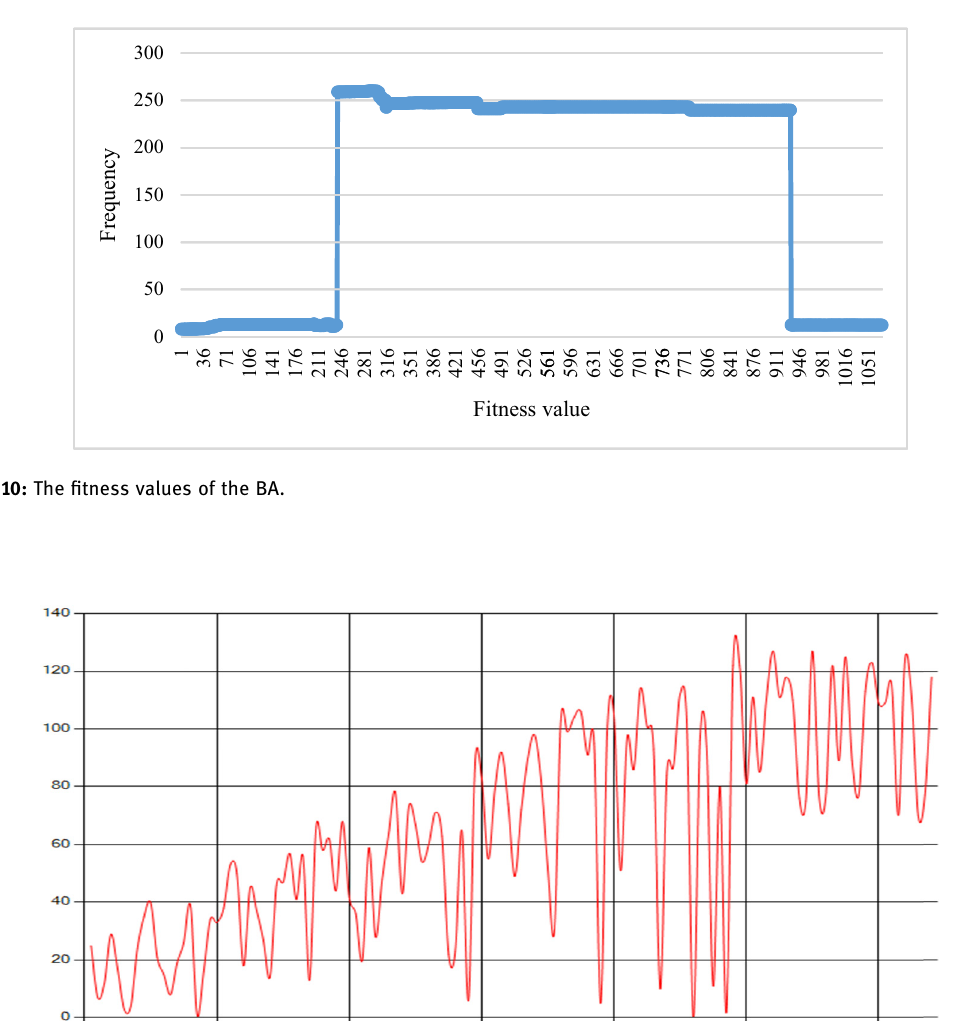
Figure 12 simulates the interface of construction of six signi fi cant shares images and distributes one